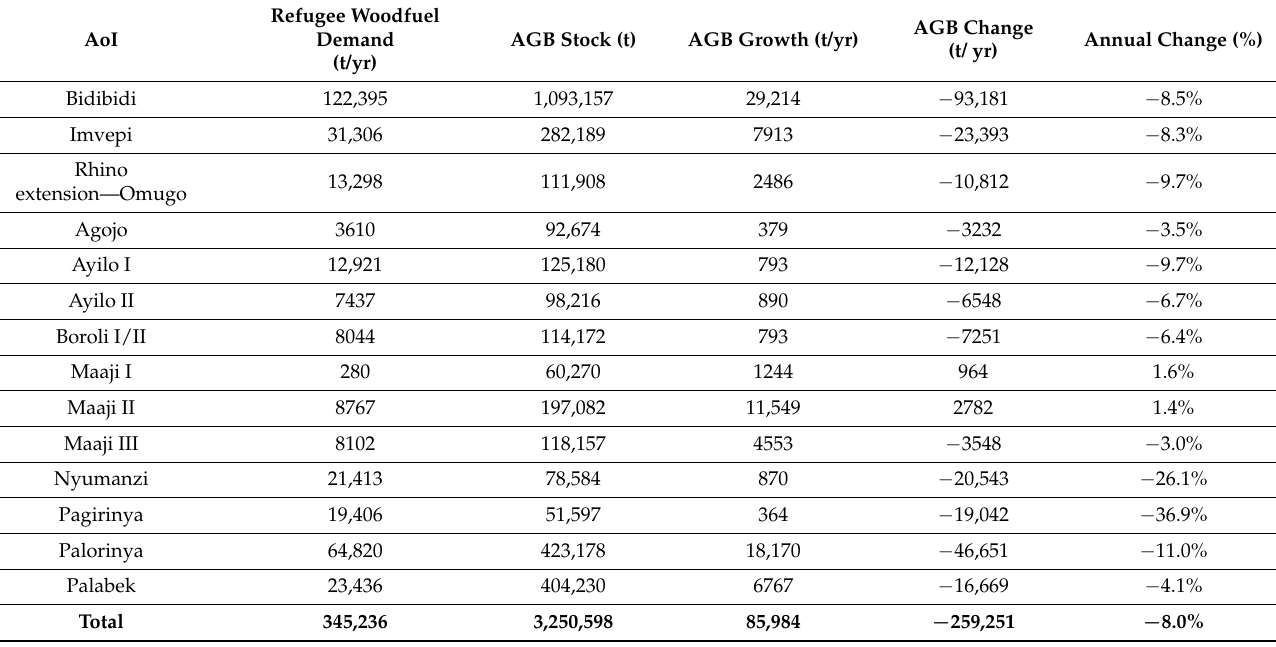
Table 11. Estimated woodfuel supply and demand within the 5 km buffer zone, northern Uganda.